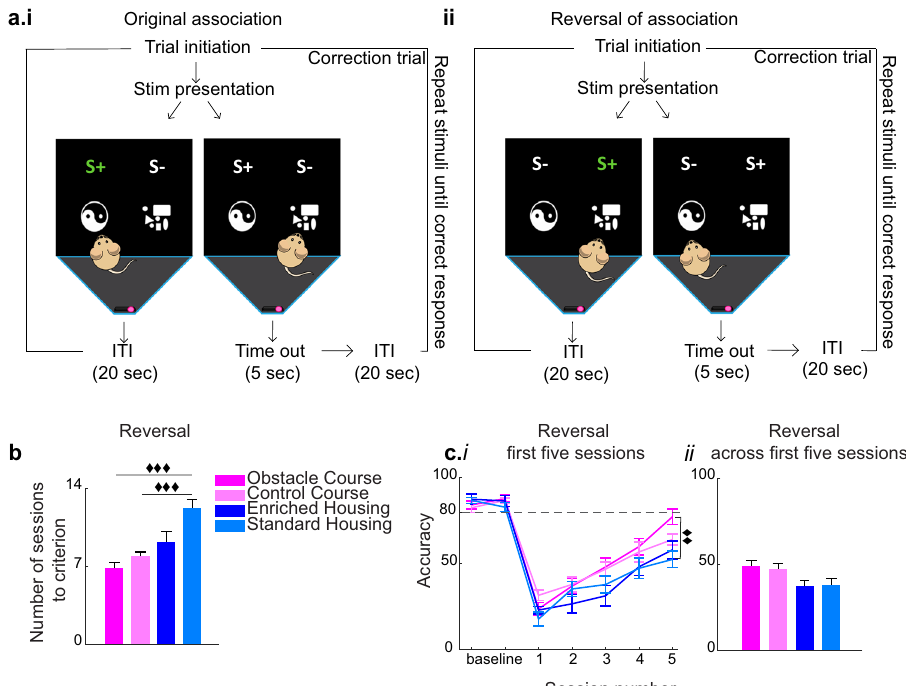
Fig. 4 PD task — enhanced cognitive fl exibility with OC and CC training exceeds EH effects. a Schematic representation of the pairwise visual discrimination (PD) experiment. ai-ii Stimulus-reward association learning. ai Original association: animal receives reward upon contact with the S + stimulus. aii Reversal of association: previously learned S − stimuli become S + stimuli and are associated with reward. b Mean session number to reach criterion (performance of 80% accuracy on two successive sessions) in the reversal phase per group (group effect p < 0.001), with the OC ( p < 0.001) and CC ( p < 0.001) groups requiring signi fi cantly fewer sessions compared to the SH group. ci Group percent accuracy on the fi rst fi ve reversal sessions, with a main effect of session ( p = 0.003) and an effect of group on the fi fth session ( p < 0.001), with the OC group performing signi fi cantly higher than the SH group on session fi ve. cii Mean accuracy across the fi rst fi ve reversal sessions for each group, with a group main effect ( p = 0.034). Post hoc independent samples t -test did not reveal group pairwise differences. ♦♦ p < 0.01, ♦♦♦ p < 0.001 indicate a signi fi cant difference between groups (two-tailed independent samples t -test, Bonferroni correction p = 0.0083). Error bars represent s.e.m. across